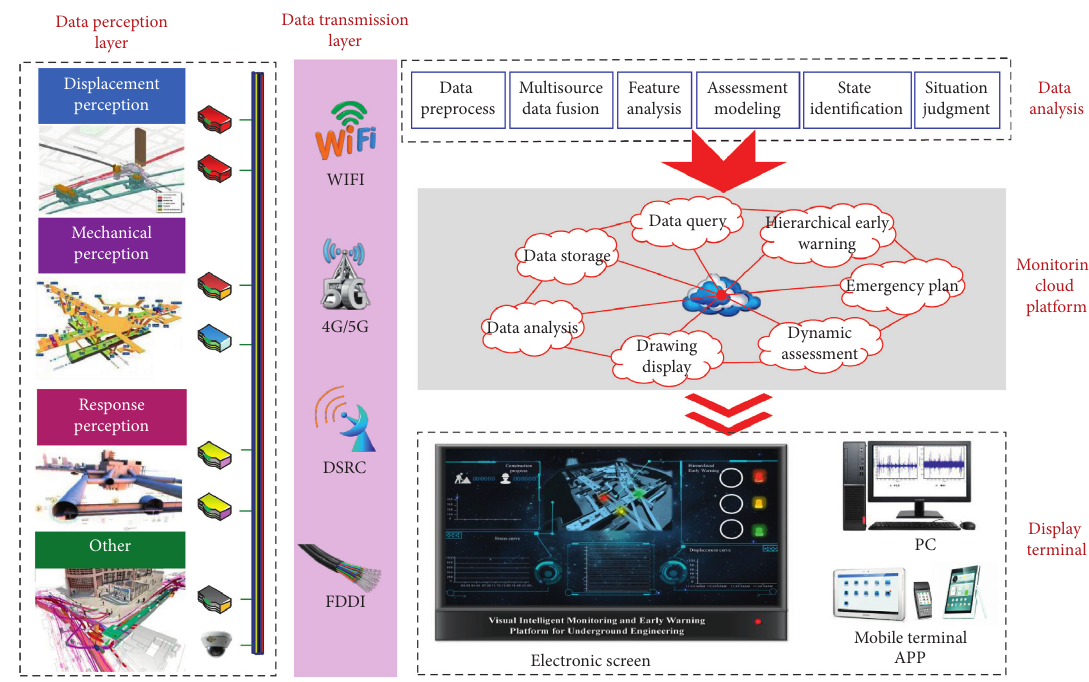
Figure 10: Intelligent automated monitoring